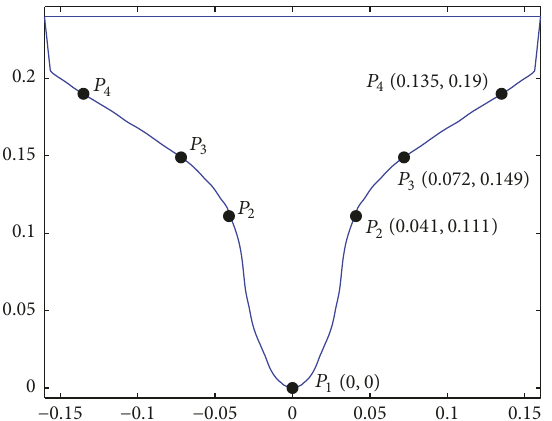
Figure 4: Bow flare section and pressure sensor locations used in MPS simulation applied by Aarsnes (1996).